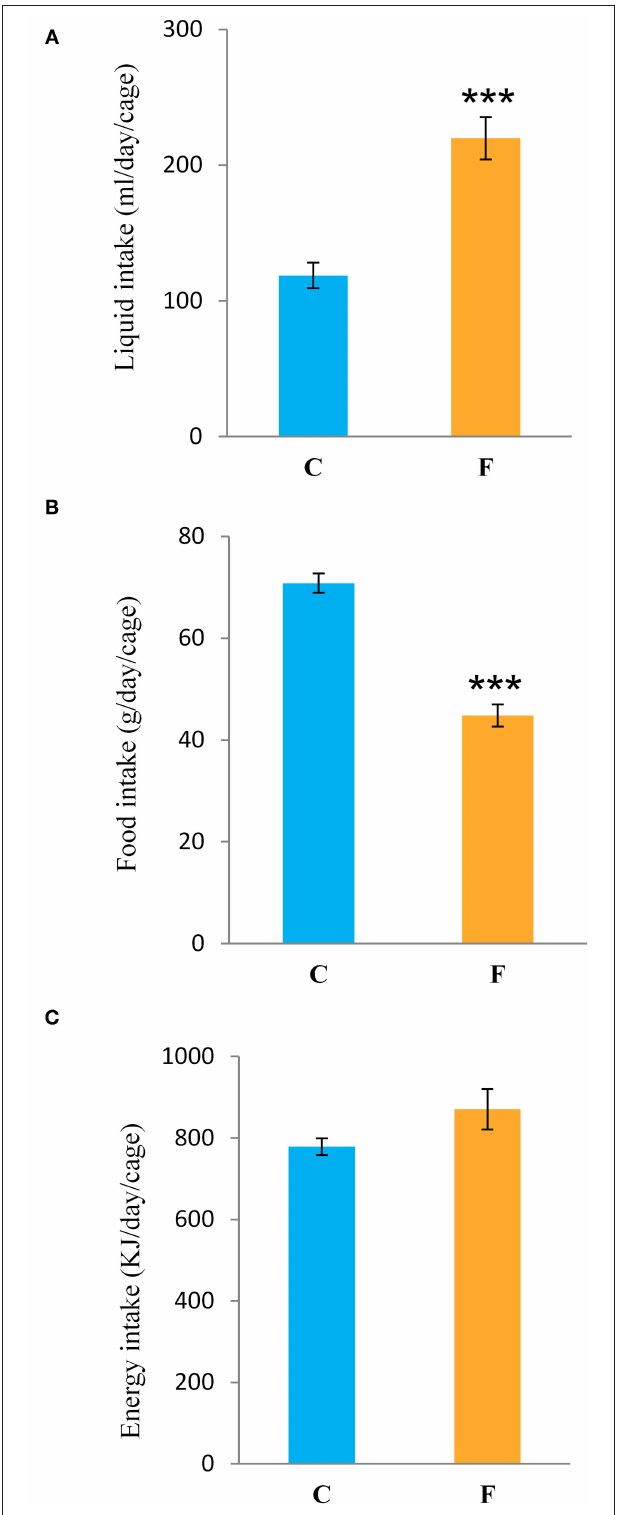
FIGURE 1 | Liquid, food, and energy intake of female rats fed with 10% fructose diet for 9 weeks. (A) Liquid, (B) food, and (C) energy intake were measured per day and per cage. Values are expressed as mean ± SEM ( n = 3 cages). Statistical significance of between-group differences (Student’s t -test): *** P < 0.001, F vs. C. C, control group; F, fructose-fed